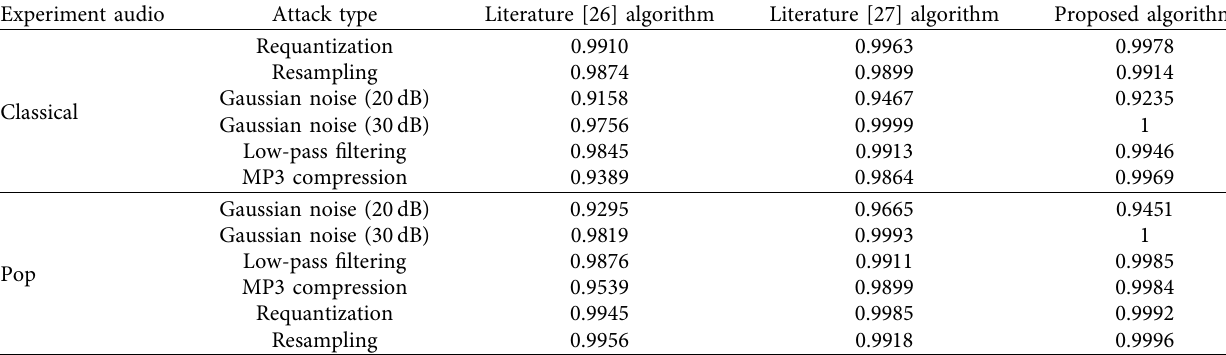
Table 3: The experimental results of the proposed algorithm are compared with those of literature algorithms (NC value). Experiment